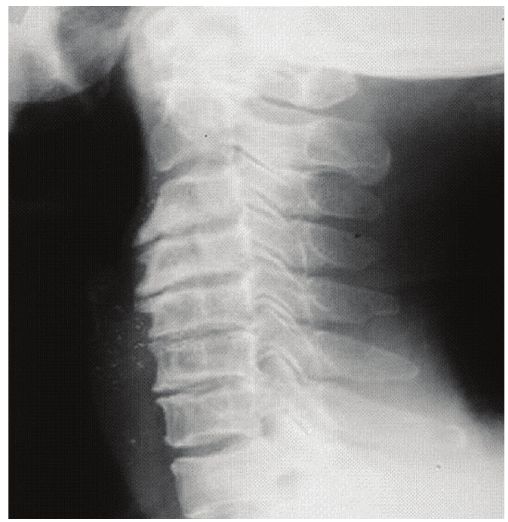
Figure 1: Radiographic representation of cervical spondylosis.